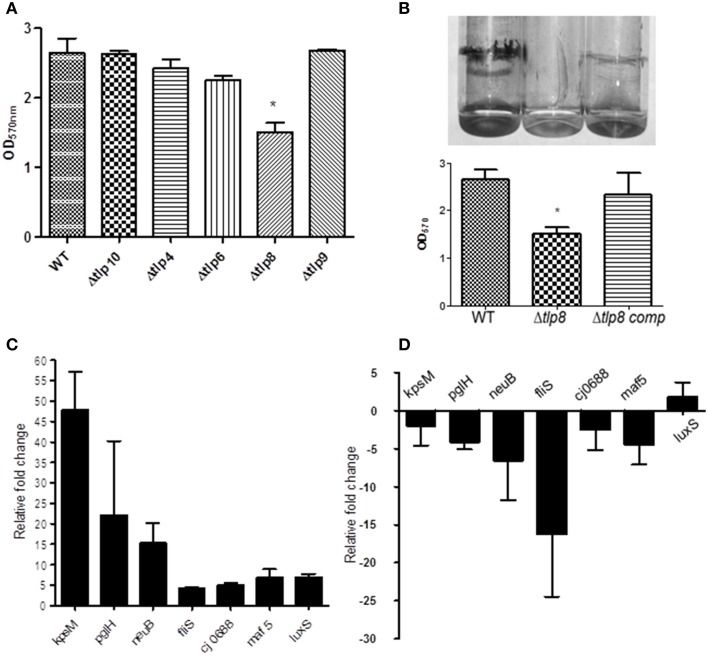
Contribution of tlps to biofilm formation. (A) Biofilm was assessed by crystal violet staining. One ml of C. jejuni cultures (OD600 of 0.05) was incubated in borosilicate tubes microaerobically for 72 h, the tubes were washed with distilled water and stained using (1%) crystal violet. Extra stain was removed by washing and the biofilm were suspended in 1 mL DMSO (80%) for quantification by a spectrophotometer. Each bar represents the mean ± SE of 3 independent experiments. *P ≤ 0.05. (B) The Δtlp8 mutant shows decreased biofilm formation and this defect was restored in the complemented strain. Each bar represents the mean ± SE of 3 independent experiments, *P ≤ 0.05. (C,D) Transcriptional changes in biofilm associated genes in the Δtlp8 mutant measured by qRT-PCR using 3 day old biofilm cultures (C) and overnight grown planktonic culture (D). The difference in gene expression relative to the WT was determined by the threshold cycle (CT) method. The assay was repeated three times. The data represent the mean relative fold change in expression ± SE.